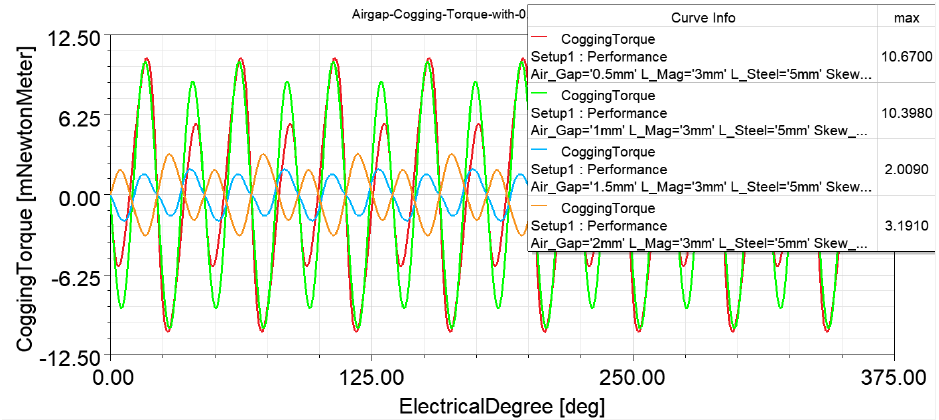
Figure 9. Cogging torque for different air gap values of 0.5, 0.1, 1, 1.5, and 2 mm for the 0.12 skewed magnet design.